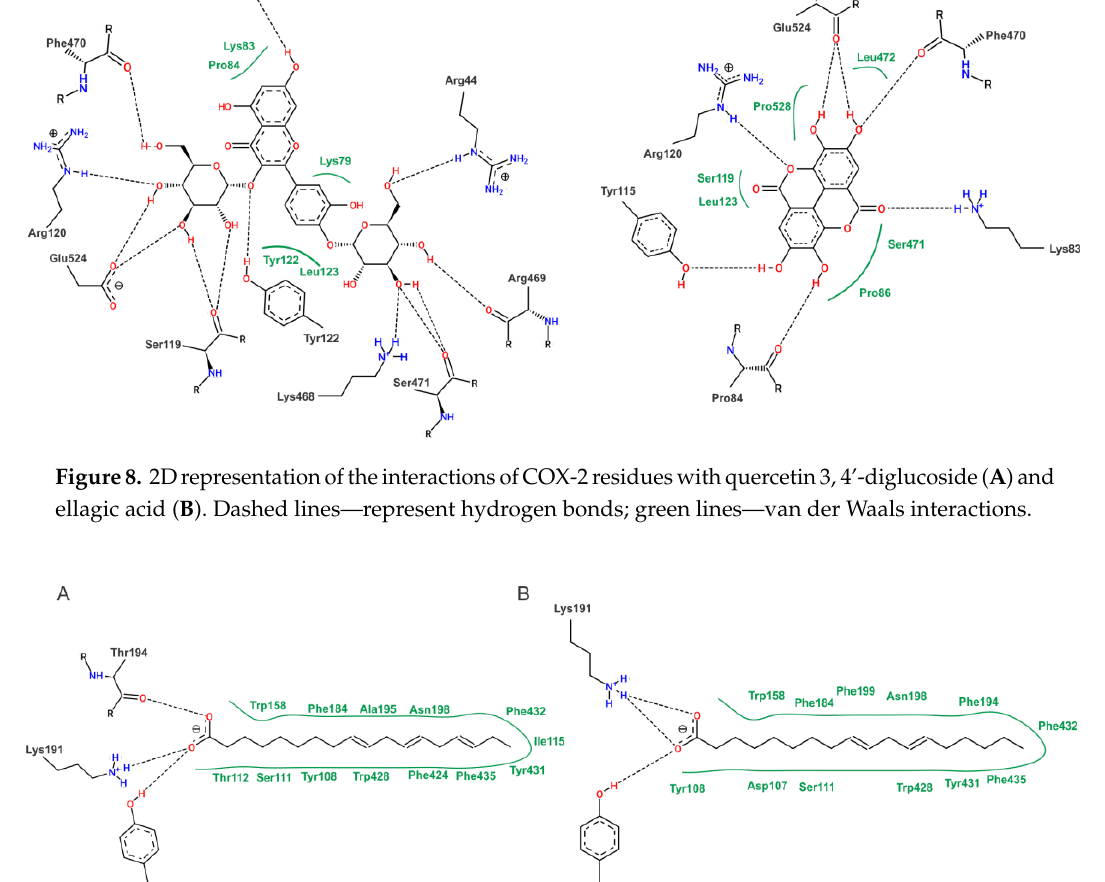
Figure 8. 2D representation of the interactions of COX-2 residues with quercetin 3, 4 ’ -diglucoside ( A ) and ellagic acid ( B ). Dashed lines — represent hydrogen bonds; green lines — van der Waals interactions.